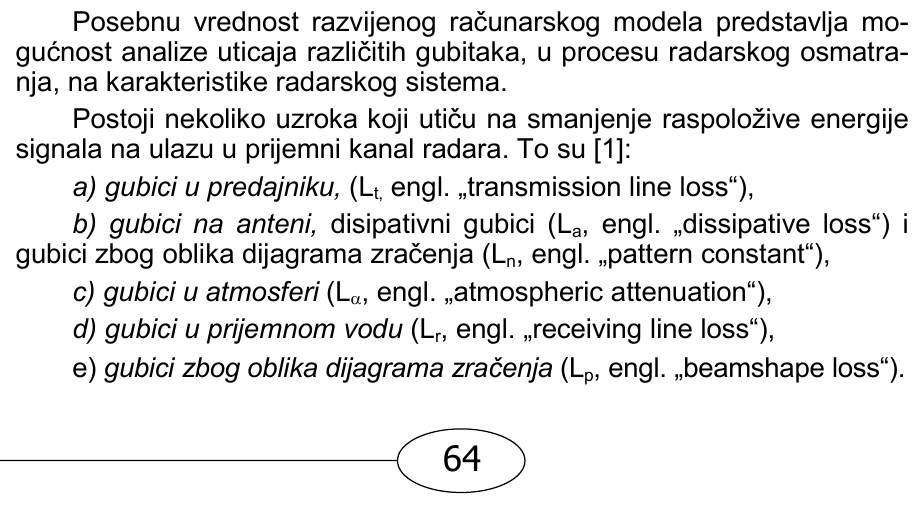
, engl. „beamshape p